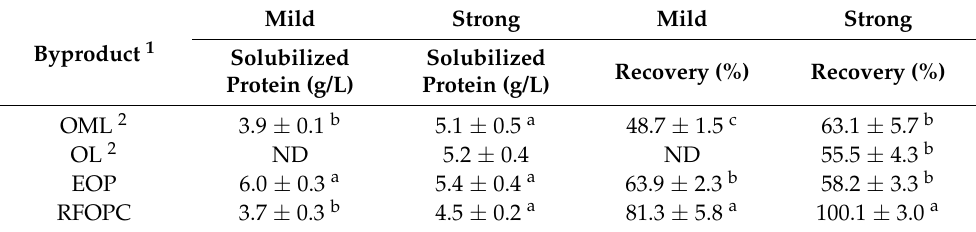
Table 5. Amount of protein solubilized (mg/100 g of byproduct, dry basis) and recovery (%, dry basis) obtained after the integration of antioxidants and alkaline extraction under mild (NaOH 0.4 M, 80 ◦ C, 4 h) and strong alkaline conditions (NaOH 0.7 M, 100 ◦ C, 4 h).